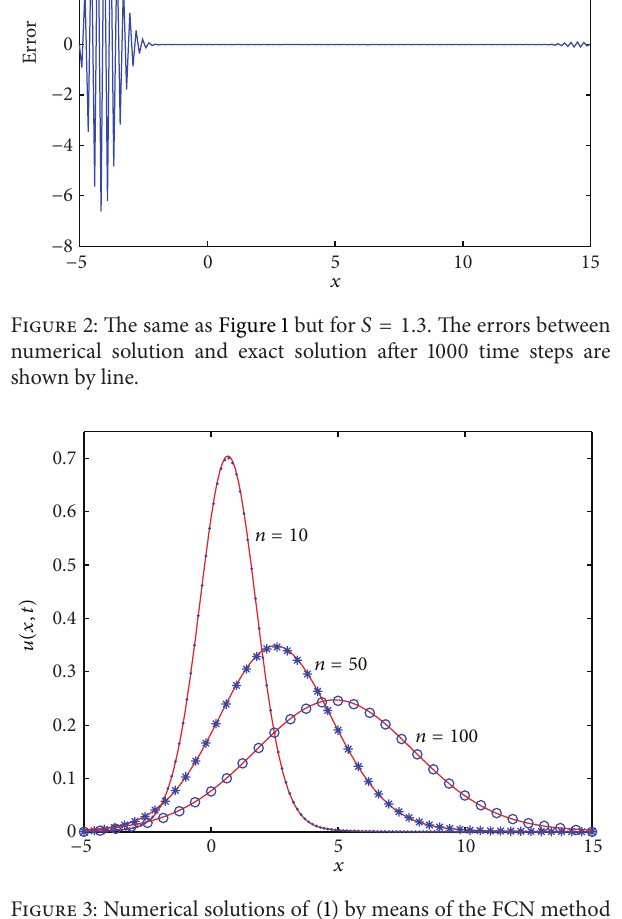
Figure 3: Numerical solutions of (1) by means of the FCN method for Δ𝑥 = 1/40 and 𝑆 = 100 . The numerical solutions are shown after 10(dots),50(stars),and100(circles)timesteps.Thelinescorrespond to the exact